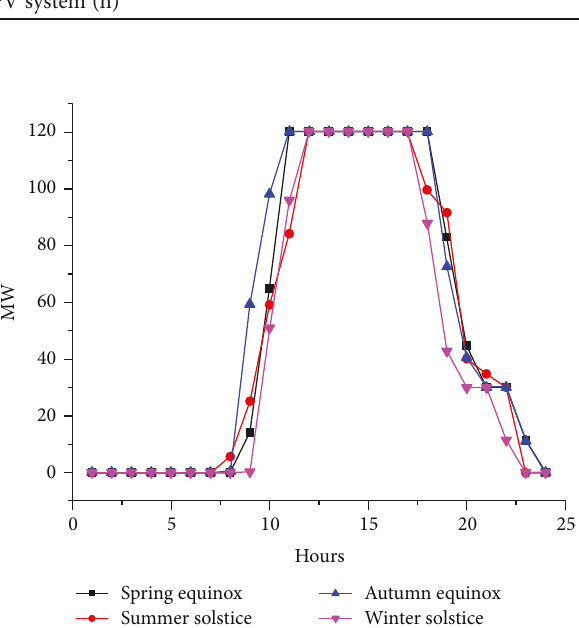
Figure 11: Comparative analysis of four typical days of whole year optimization.